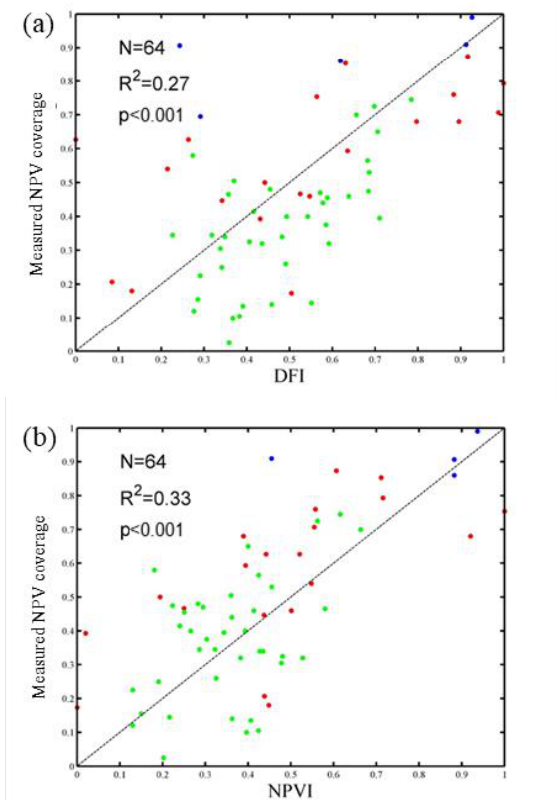
Fig.9 Relationship between measured NPV coverage and (a)DFI, (b)NPVI in 2004 (red), 2007(green) and